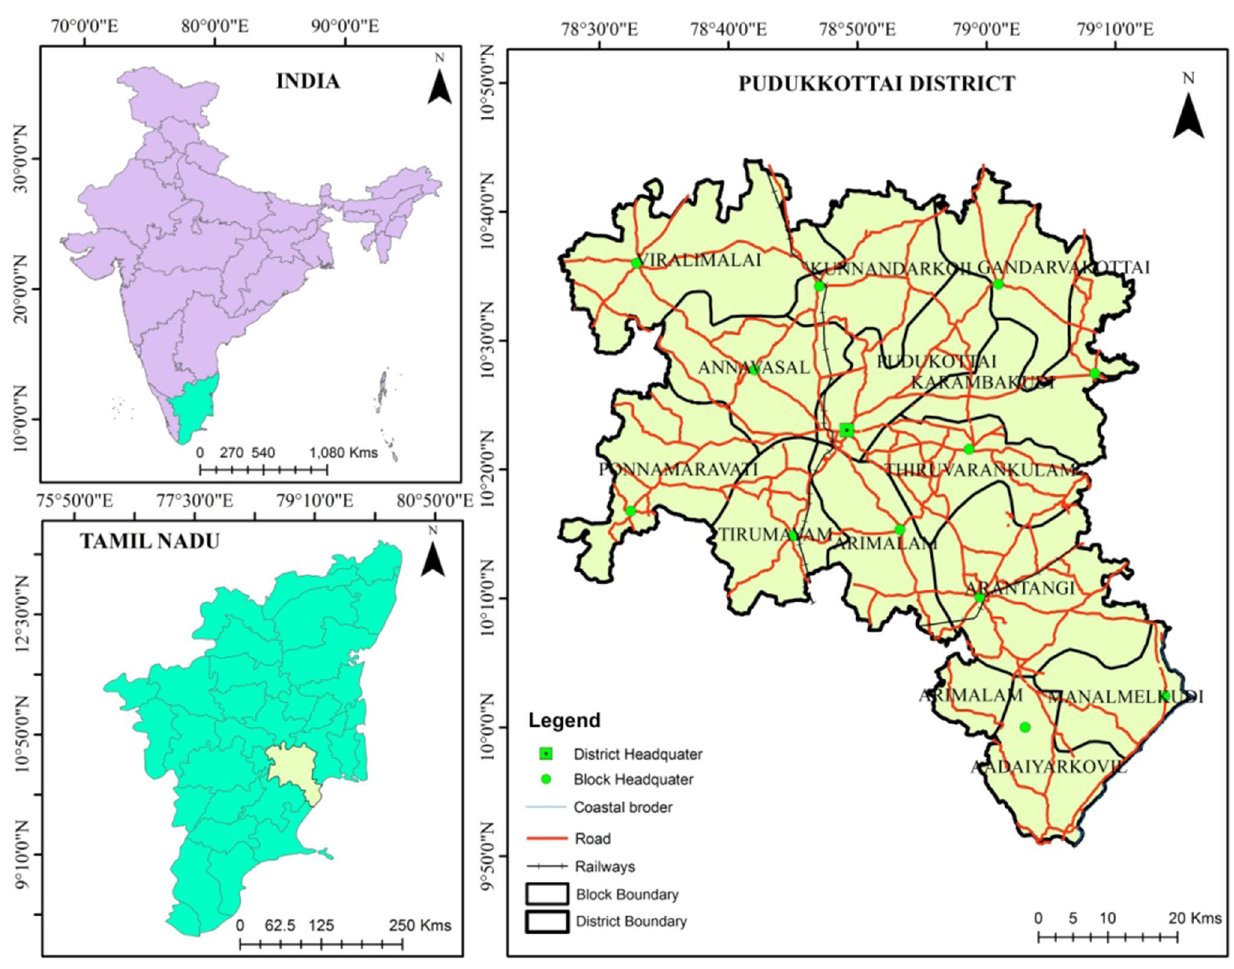
Fig. 1 Study area—Pudukkottai